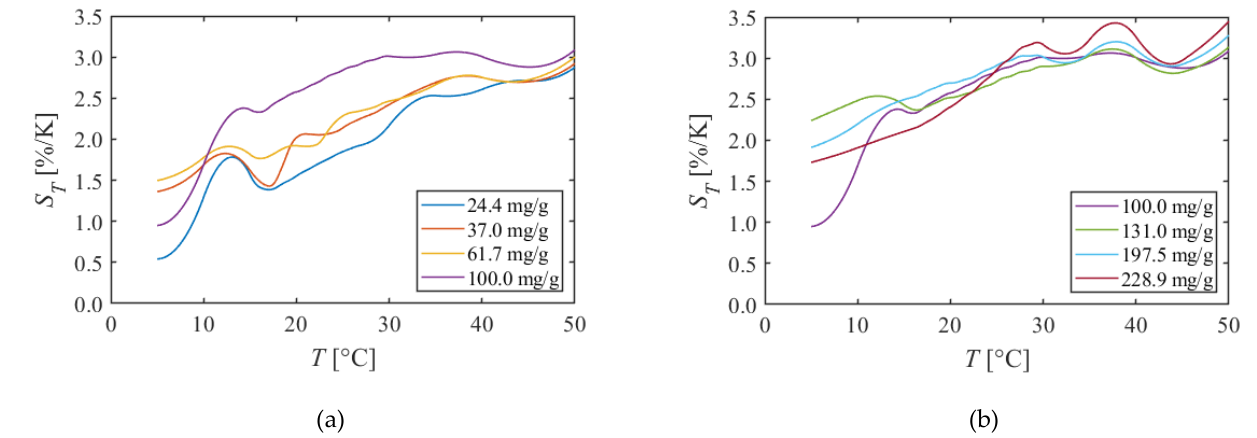
Figure 5. Temperature sensitivities of PAA + EtOH in different dye concentrations. ( a ) The dye concentration is 100 mg/g or less. ( b ) The dye concentration is 100 mg/g or more. PAA + EtOH has a temperature sensitivity of about 2.5%/K around 20 °C. It is a sufficient temperature sensitivity in wind tunnel tests that requires detecting temperature